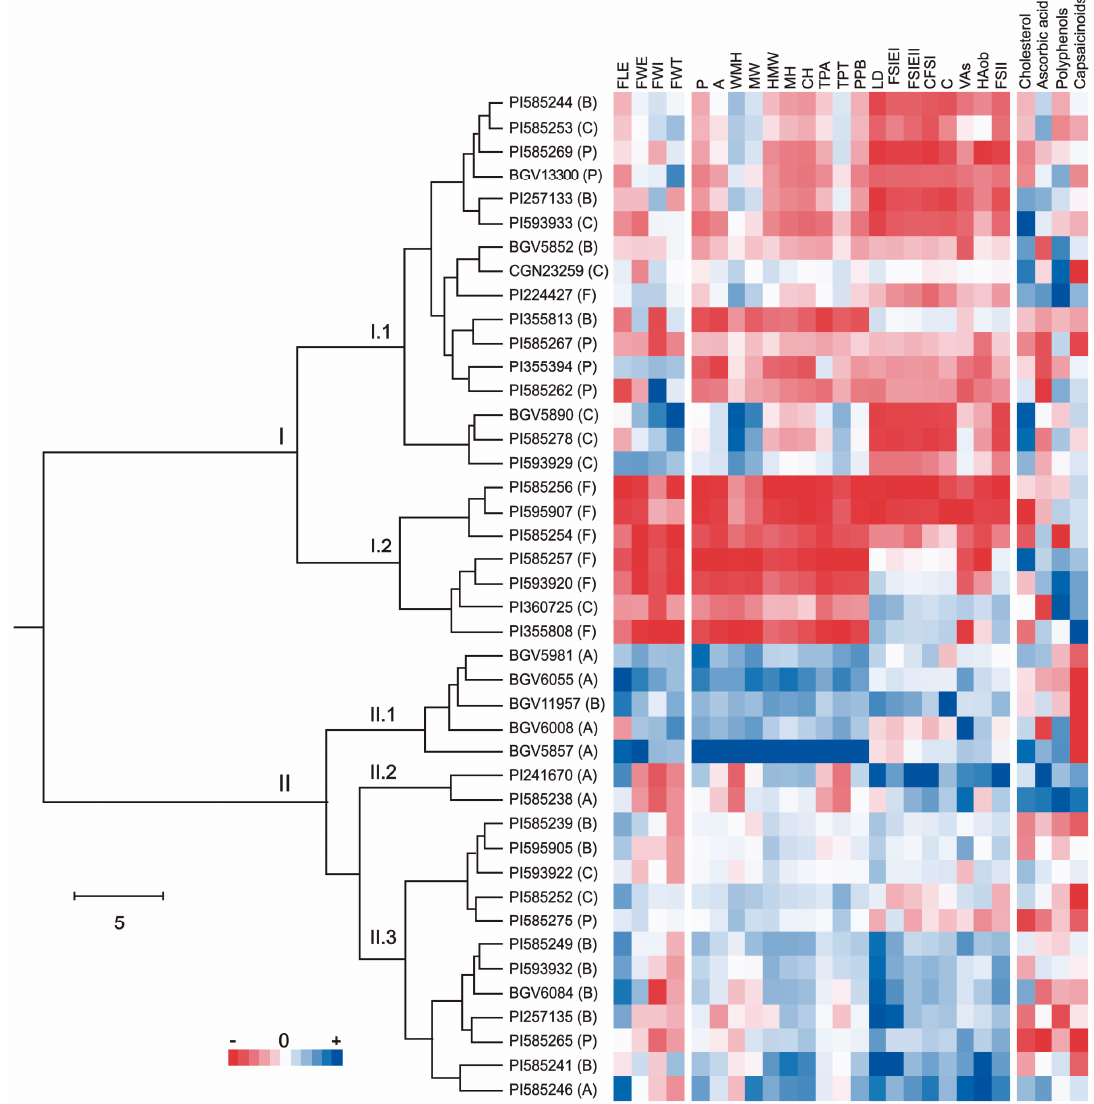
Figure 5. Cluster analysis (Ward coe ffi cient) based on four biochemical traits, four conventional fruit descriptors, and eighteen TA attributes for the forty-two Ecuadorian accessions. The color code matrix represents the variables standardized to z-scores. Letters in brackets indicate the Capsicum species (A = C. annuum , B = C. baccatum , C = C. chinense , F = C. frutescens , P = C. pubescens